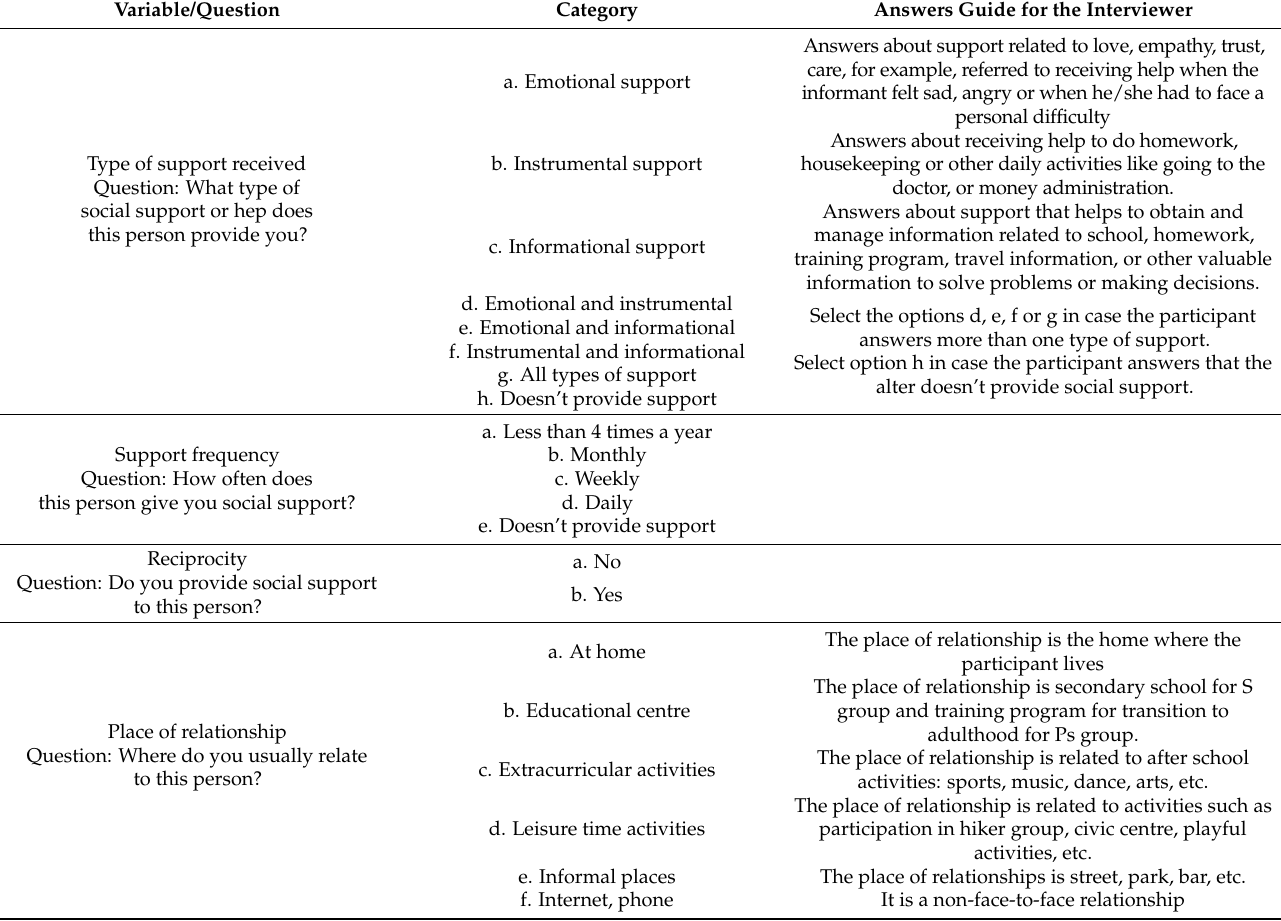
Table A1. Social support function information: variables, questions, categories, and answers guide for the interviewer. Variable/Question Category Answers Guide for the